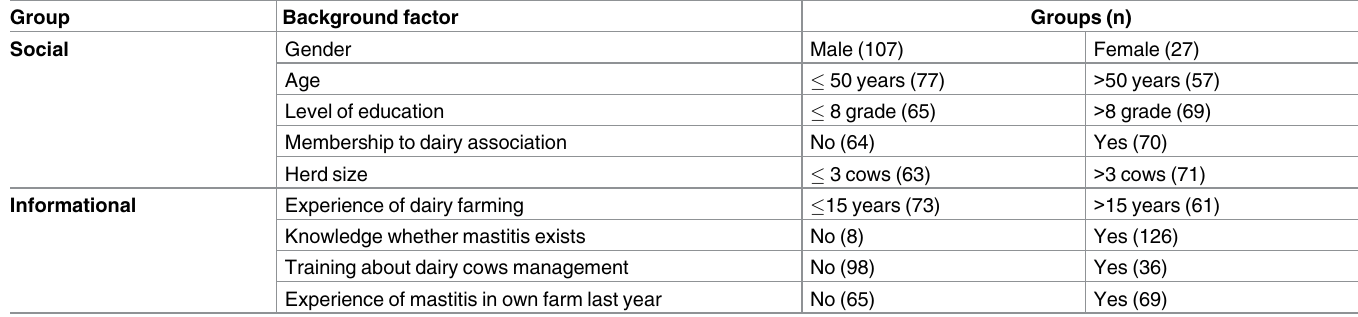
Table 4. Social and informational background factors expected to influence behavioral, normative and control beliefs of dairy farmersin Noth- Western Ethiopia.